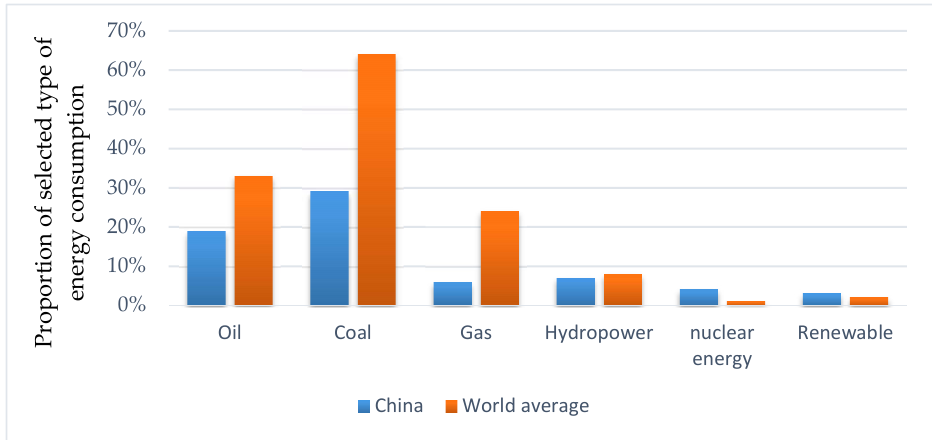
Figure 7. Comparison of energy structure between China and the world.